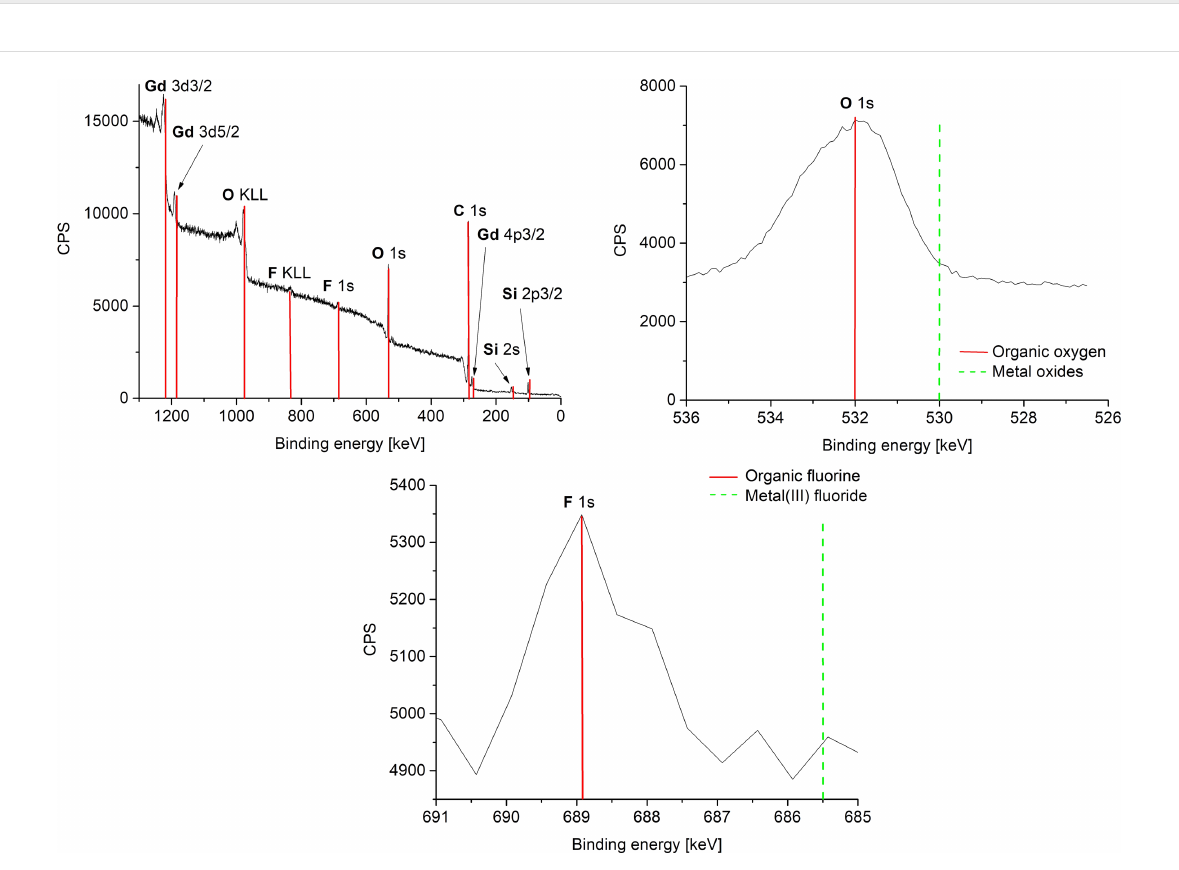
Figure 8: Overview and HR-XPS of 1.0 wt % Gd-NPs in [BMIm][NTf 2 ] from Gd(amd) 3 . The red and green bars are a guide to the eye on the binding- energy axis.